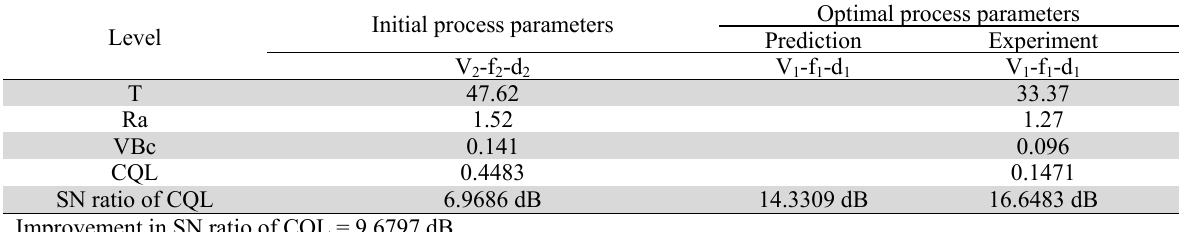
Results of confirmatory